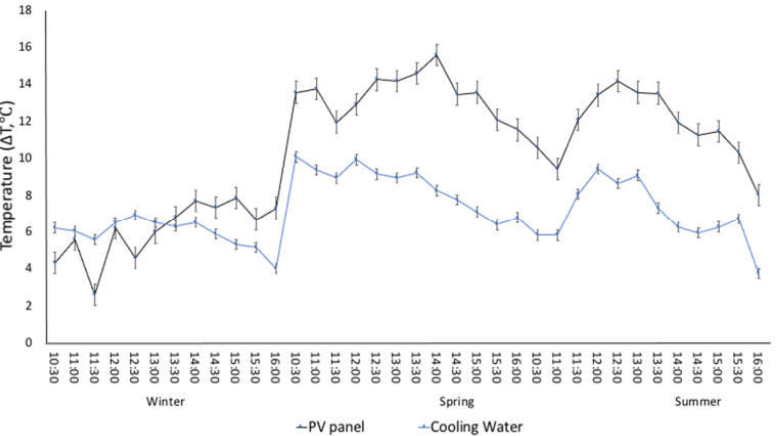
Figure 8. Changes in temperature for the PV panels and cooling water after the cooling system in winter, spring and summer.